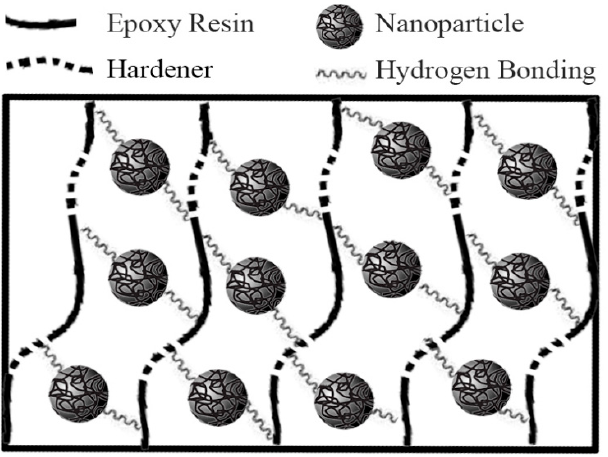
Figure 1. An illustration of the epoxy resin/UFNBRP nanocomposite structure.